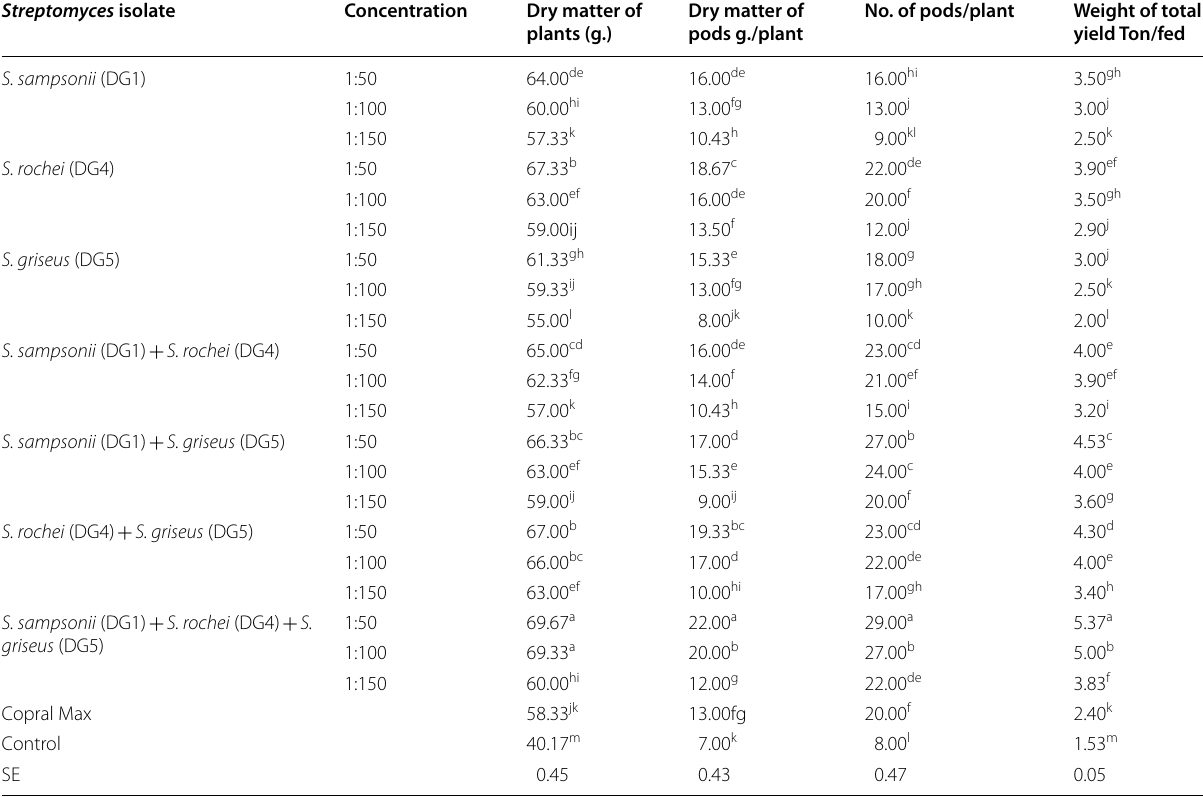
Values with the same letter, in each separate column, are not significantly different ( P